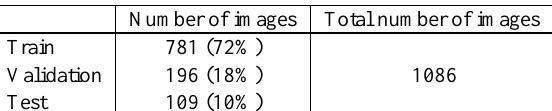
Table 2 . The number of images in each split and their percentages with respect to all training samples.